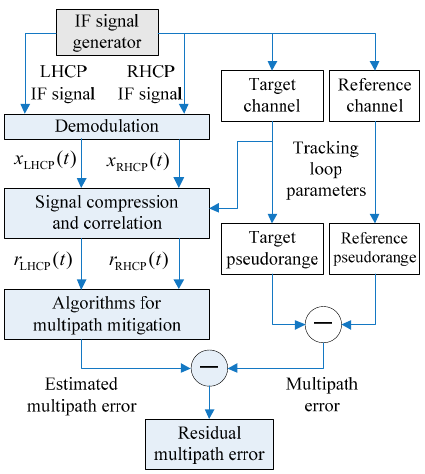
Figure 9. The diagram of the connections between the IF generator, the software receiver and the post-processing unit of simulation platform. The top left part is the IF data generator, the bottom left part is the post-processing unit with multipath mitigation algorithms, and the software receiver is on the right.